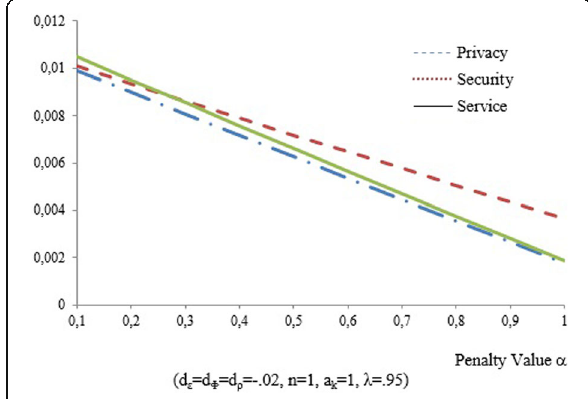
Fig. 8 Upper bounds of security v(A S ), privacy v(A P ) and service v(A G ) risk for various penalty ( α )